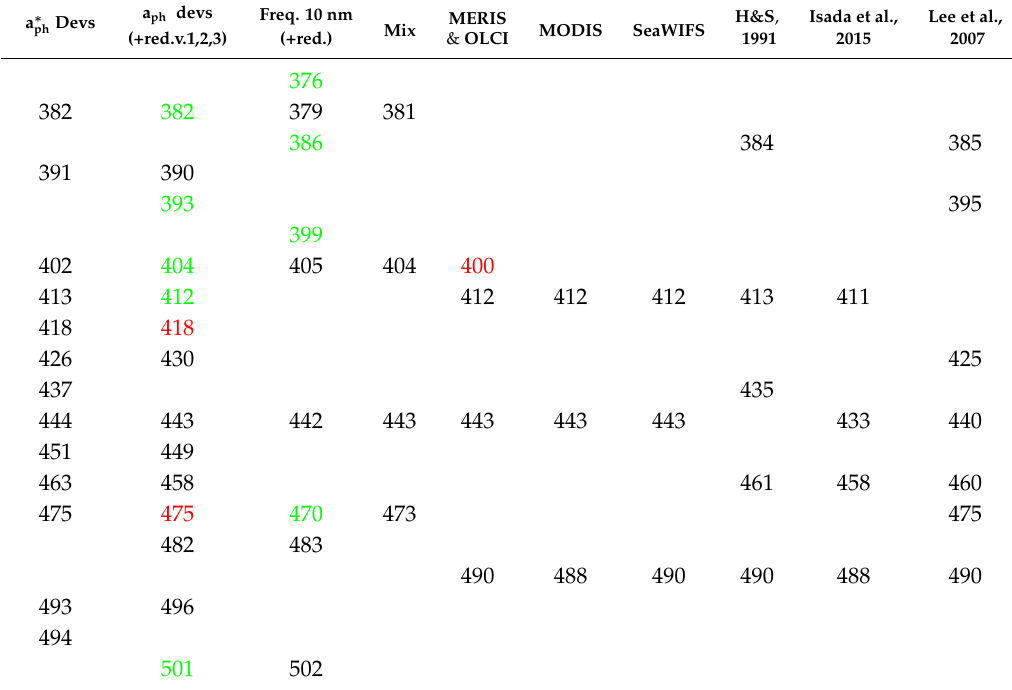
Figure 4. The second derivatives of ¯ a ∗ φ ( λ ) for each target PFT. Both the top and bottom panels show the same spectra, but the chosen wavelengths are highlighted separately for cyanobacteria (top) and diatoms and coccolithophores (bottom). Table 1. Summary of the bands chosen by different approaches (spectral resolution of 10 nm) and the bands of the existing instruments. Abbreviations for the band settings are the same as in Table 2. Medium Resolution Imaging Spectrometer (MERIS) and Ocean and Land Colour Instrument (OLCI) bands are the same, with the exception of additional OLCI bands (400 nm and 674 nm) highlighted in red. Bands in color are the bands that were excluded in order to make a subset with a smaller number of bands. The bands that were removed from ‘Freq. 10 nm’ to ‘Freq. 10 nm red.’ are in green. In the case of ‘a ∗ devs’ sets, the bands removed from the original set ‘a ∗ devs’ to ‘a ∗ devs red.v.1’ are ph ph ph in green; the bands that were further removed to ‘a ∗ devs red.v.2’ are in red; and the bands finally ph removed to ‘a ∗ devs red.v.3’ are in ph